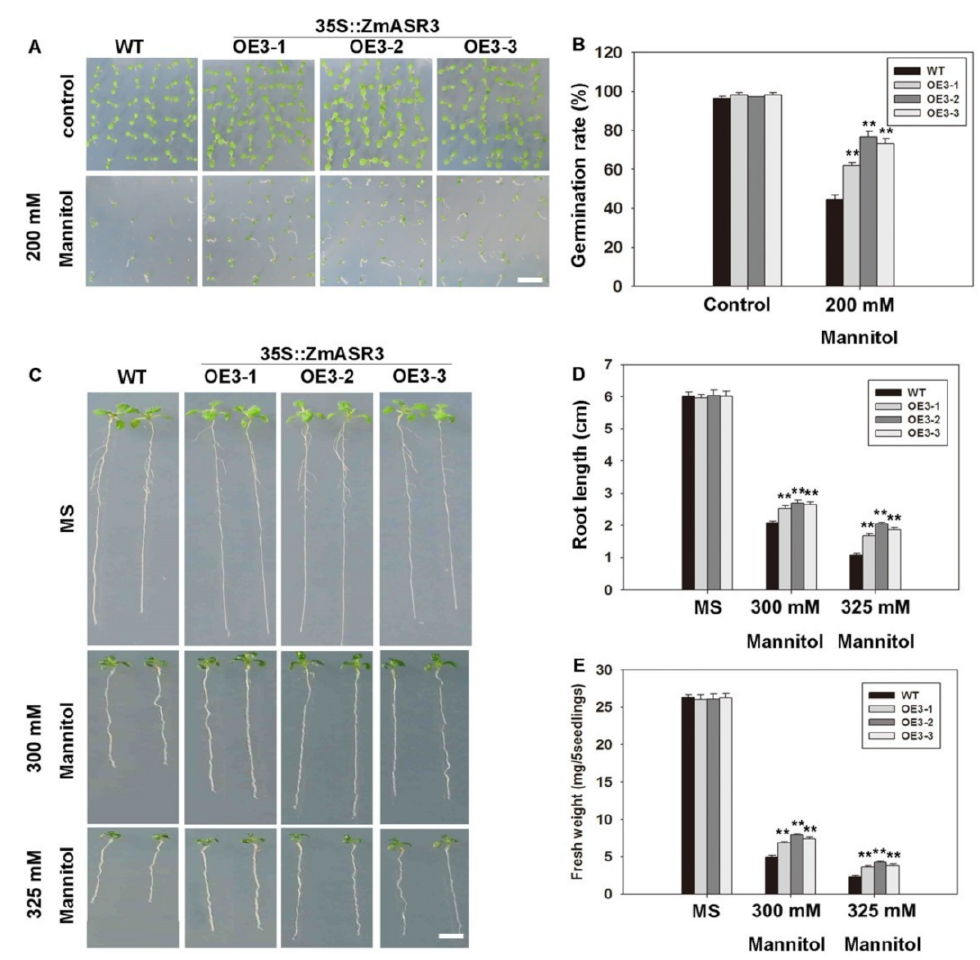
Figure 4. Overexpression of ZmASR3 enhances drought tolerance in the germination and post-germination stages in Arabidopsis . ( A ) Phenotype and ( B ) quantitative evaluation of germination rates of the wild-type (WT) and three transgenic lines. Photographs were taken eight days after germination. ( C ) Photographs and measurements of ( D ) root lengths and ( E ) fresh weights of WT and transgenic seedlings in the post-germination stage under control (Murashige and Skoog (MS)) and osmotic stress (mannitol) conditions. All samples were measured in three independent experiments (each with 100 seeds for each line). Vertical bars indicate means ± S.E. ( n ≥ 3). Significant di ff erences: ** p < 0.01. Scale bar = 1